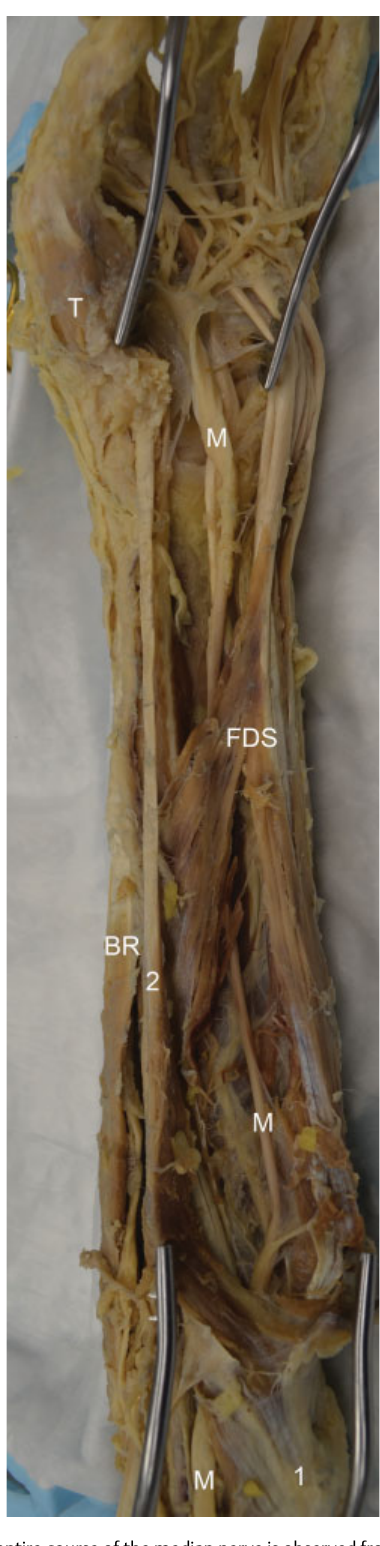
Fig. 3 The entire course of themedian nerveisobserved from the cubital fossa,under the fl exormuscles,andthendistallymakinga360-degreeturn until it branches distal tothe transverse carpal ligament. 1, common fl exor tendon originating from the medial epicondyle of the humerus; 2, fl exor carpi radialis; BR, brachioradialis; FDS, fl exor digitorum super fi cialis; M, median nerve; T, thenar